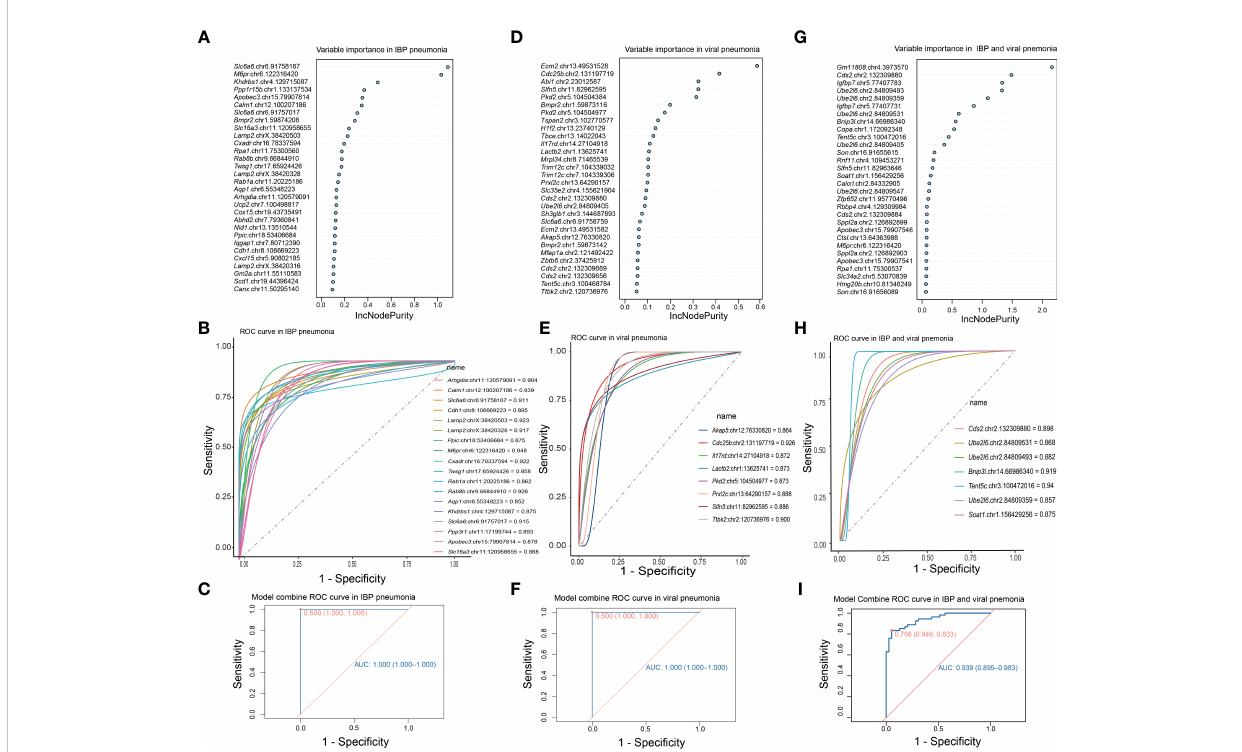
FIGURE 6 DRE signatures distinguish IBP and viral pneumonia. (A) The top 30 signi fi cant DRE sites identi fi ed by random forest in IBP pneumonia. (B) 19 DRE sites in IBP pneumonia with AUC greater than 0.85. (C) The ROC curve obtained from logistic regression of these 19 sites. (D) Random forest identi fi es the top 30 signi fi cant DRE sites in viral pneumonia (E) and 8 DRE sites in viral pneumonia with AUC greater than 0.85. (F) The ROC using the combination of the above 8 DRE sites. (G) Random forest identi fi es the top 30 signi fi cant DRE sites shared by IBP and viral pneumonia. (H) 7 DRE sites in IBP and viral pneumonia with AUC greater than 0.85. (I) The ROC curve using the combination of the above 7 DRE sites. The top 30 sites are ranked by their contribution to the Increase in Node Purity (IncNodePurity). ROC, receiver operating characteristic; AUC, the area under the ROC